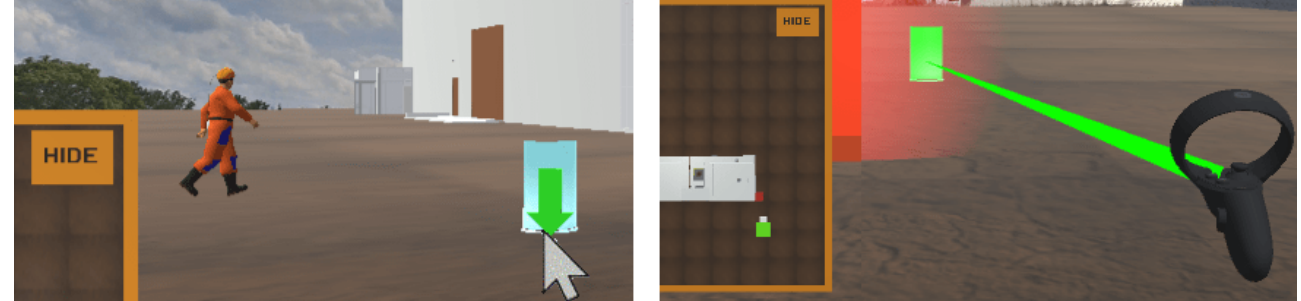
Figure 6. Left : A user using the desktop application. Right : A user using the HMD